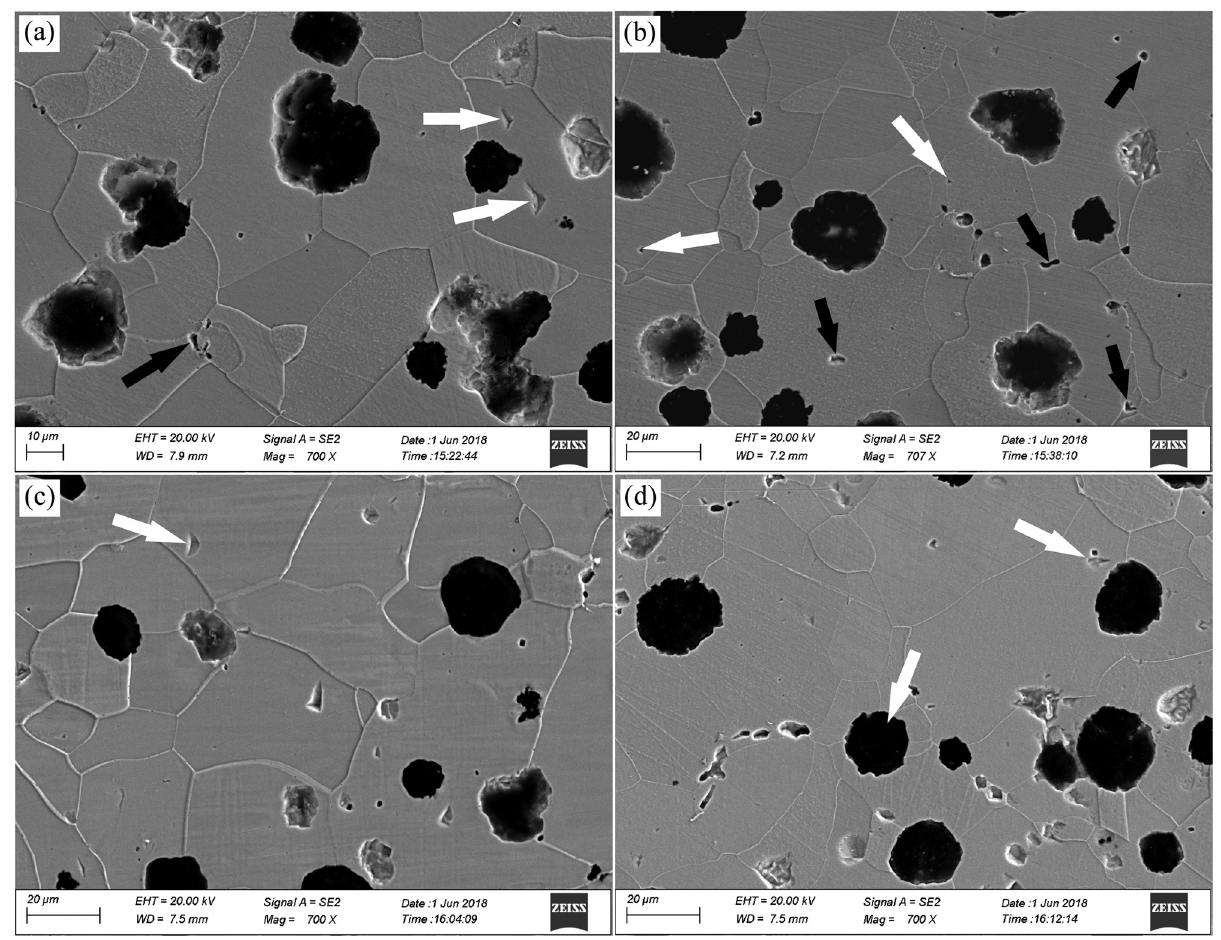
Figure 4: SEM images of ⅓ radius away from the cast center: ( a ) φ A = 15; ( b ) φ A = 20; ( c ) φ A = 25; ( d ) φ A =